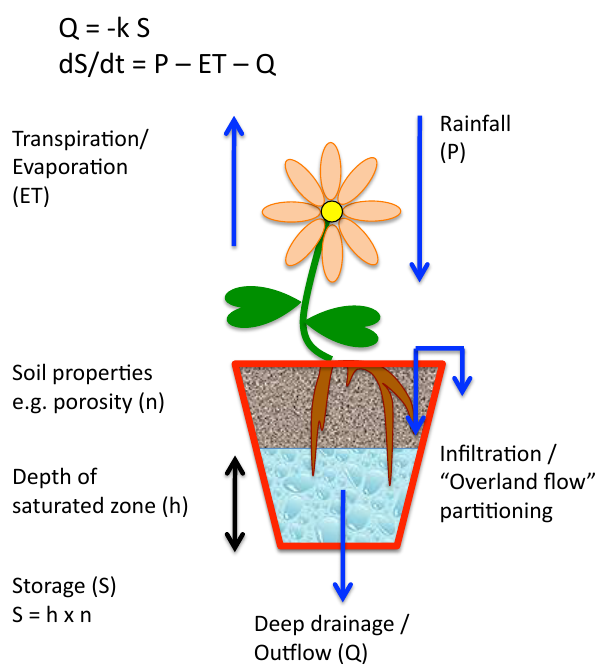
Fig. 1. Cartoon illustration of the flowerpot analogy for a catchment used in teaching catchment hydrologists. Containing vegetation, a root zone, a vadose zone, a saturated zone and soil; and modeling processes of rainfall, infiltration, surface flow partitioning, drainage, outflow, evapotranspiration and water storage in the soil, the flower- pot is an effective example of PCK commonly employed by catch- ment hydrologists. By employing simple parameterizations of the fluxes and a water balance over the flowerpot, a simple runoff model can be made and